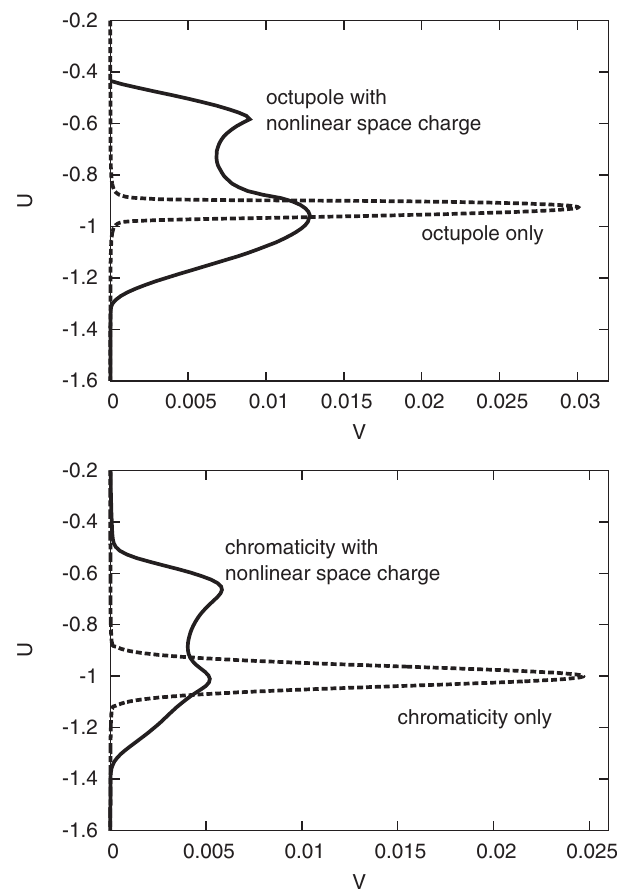
FIG. 2. Stability diagrams obtained with the dispersion rela- tion [Eq. (7)]. Top: for an octupole only (a beam with the KV distribution, linear space charge) and for a combination of this octupole with nonlinear space charge (waterbag distribution); bottom: for the chromaticity effect only (with linear space charge) and for the combination with nonlinear space charge. V (cid:7) iU is the normalized impedance; for the definition see Eq.